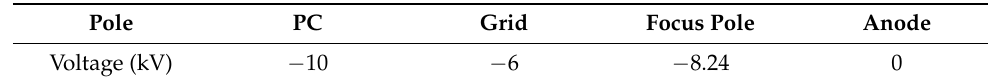
Figure 2. Structural diagram and physical drawing of the streak tube. Table 1. Voltage of the